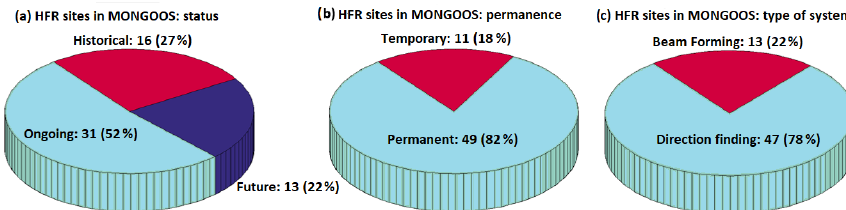
Figure 8. Pie charts showing the number and percentages of HFR systems in MONGOOS in terms of status, permanence, and